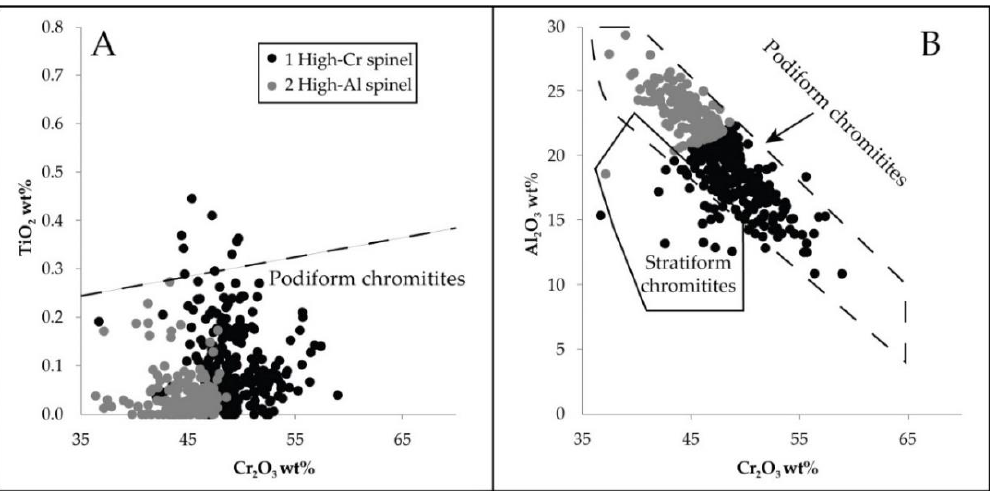
Figure 7. Chemical variations of investigated chromian spinels. ( A ) Cr 2 O 3 vs. TiO 2 ; ( B ) Cr 2 O 3 vs. Al 2 O 3 . Classification fields after [31]. Black dots: high-Cr spinels, grey dots: high-Al spinels.